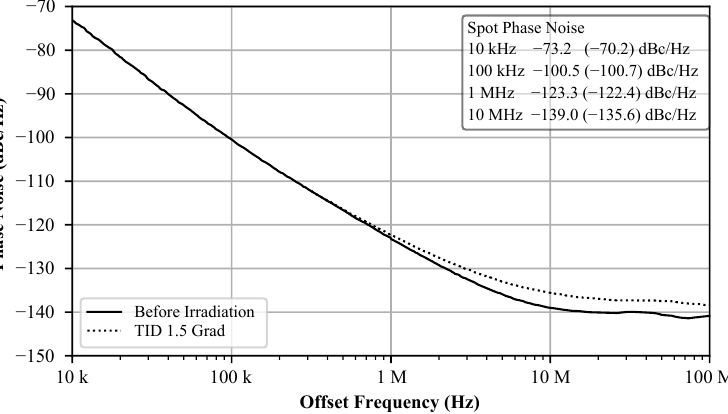
Figure 6. Open loop LC DCO phase noise measurement. Pre- and post-irradiation measurements are shown in solid and dashed lines, respectively. Values in parentheses indicate post-irradiation performance. Noise floor above 10MHz is limited by clock distribution